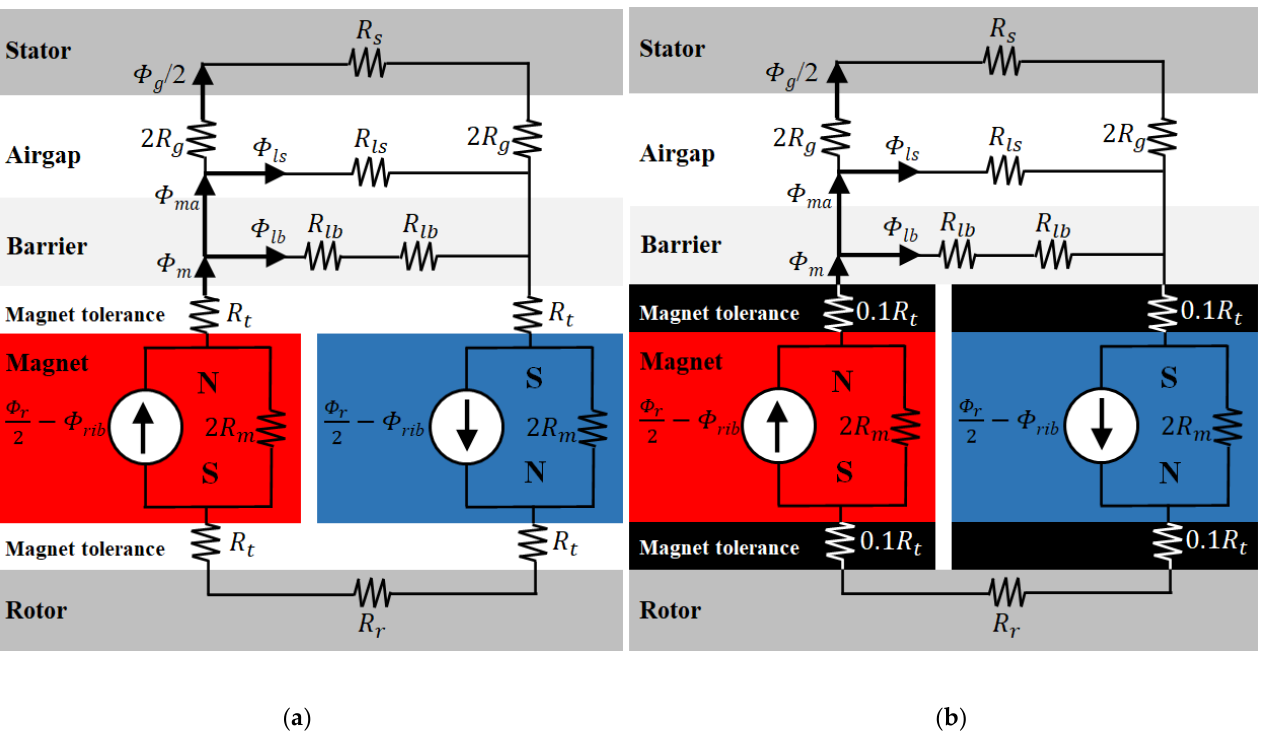
Figure 3. Magnetic circuit for the half pole pair of the interior permanent magnet synchronous motor (IPMSM): ( a ) conventional model; ( b ) conventional model with ferrofluid.